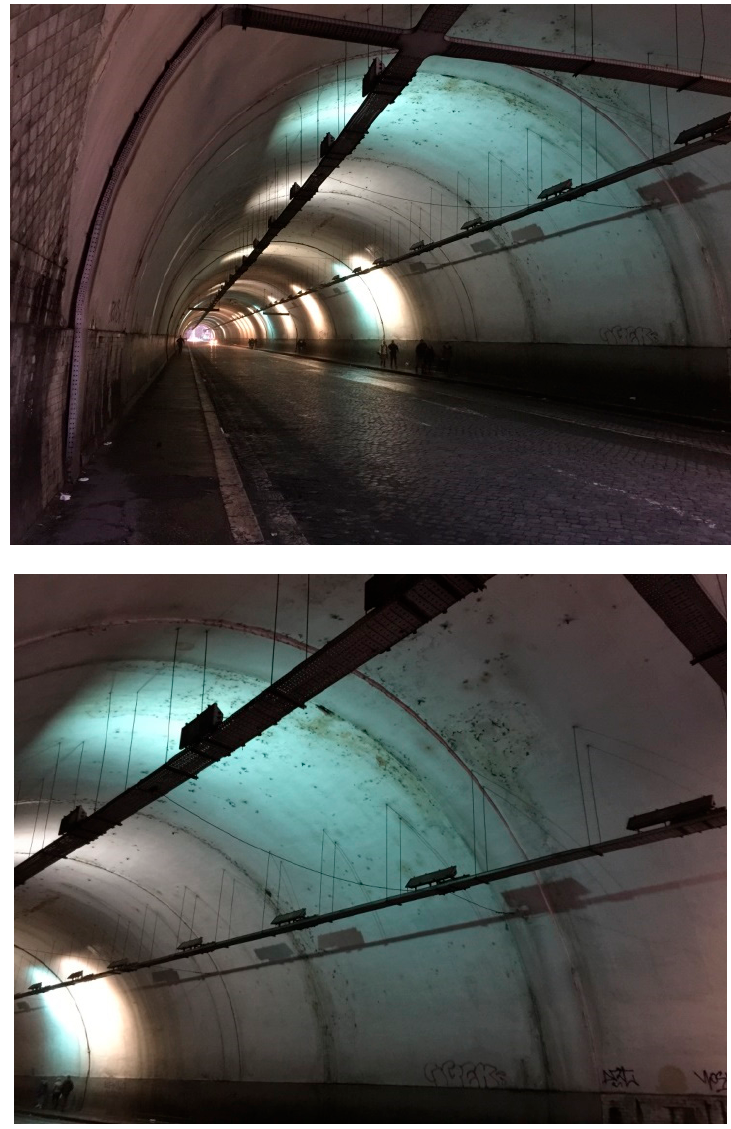
Figure 50. Photographs showing the status of the Umberto I Tunnel in Rome nearly 11 years after the renovation. Photographs taken 4 March 2018 at 17:00 (Copyright by N. Serpone).